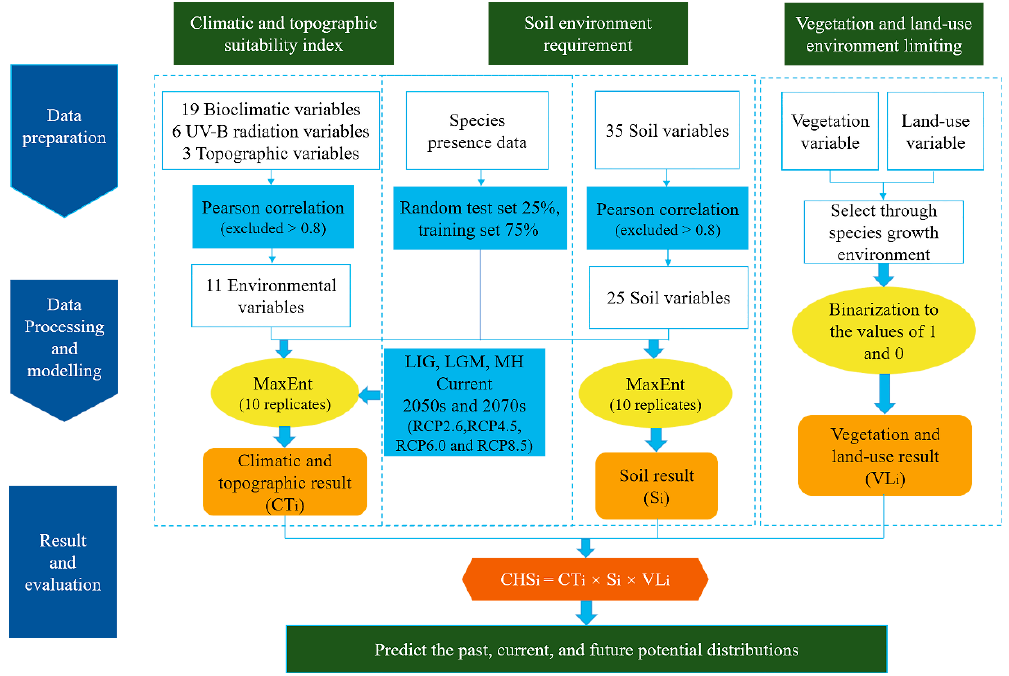
Figure 2. Modelling process in a flow diagram.